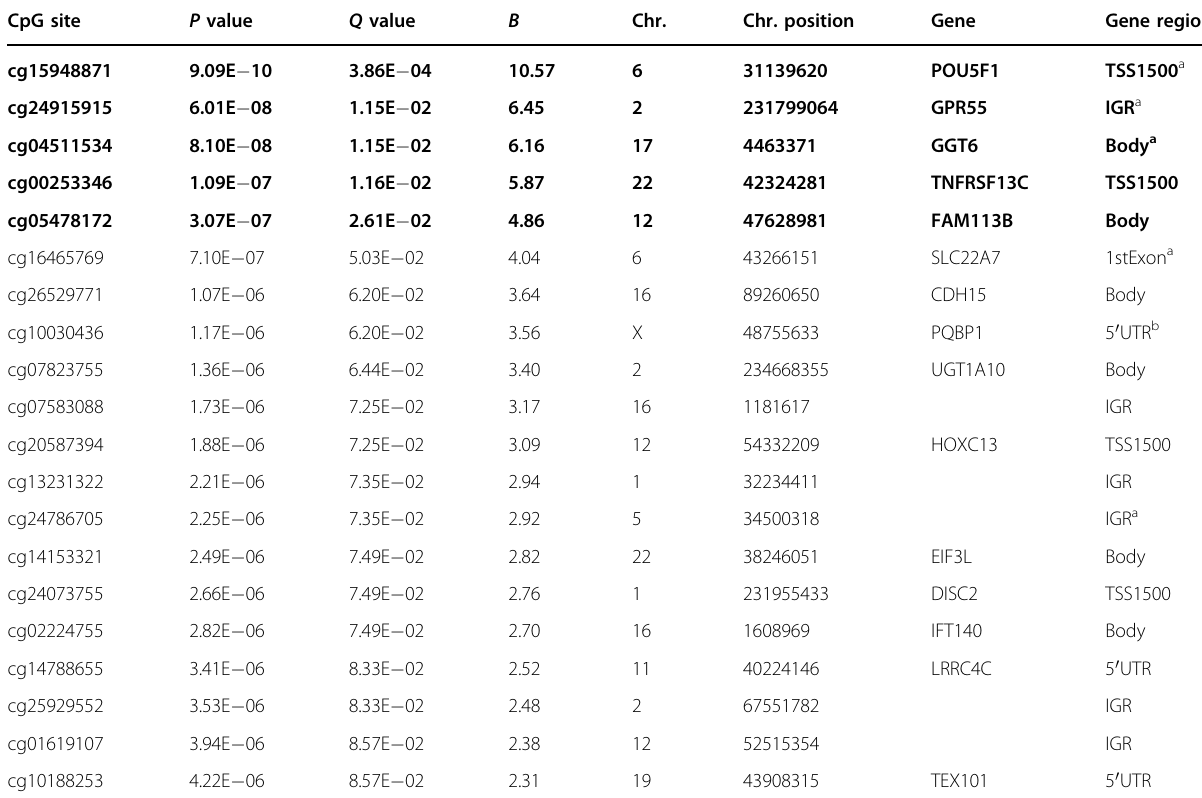
Table 2 Top 20 differentially methylated CpG sites resulting from the comparison between BPD + T patients ( N = 49) and BPD-T patients and CTL ( N =